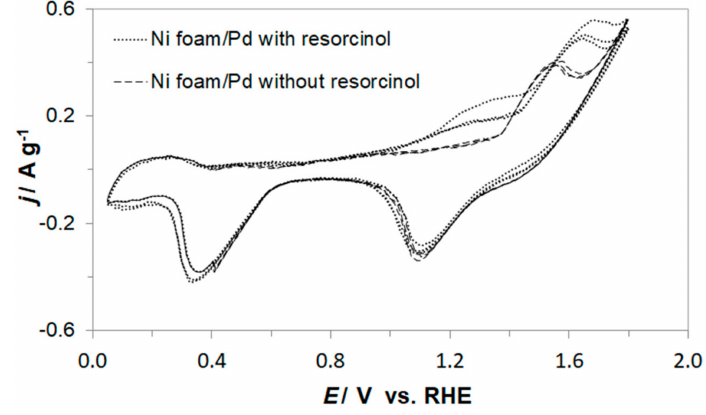
Figure 4. Cyclic voltammograms recorded on Pd-modified Ni foam electrode surface in 0.1 M NaOH supporting solution, carried out in the absence and presence of resorcinol (at 1 × 10 − 3 M), at a sweep-rate of 50 mV s − 1